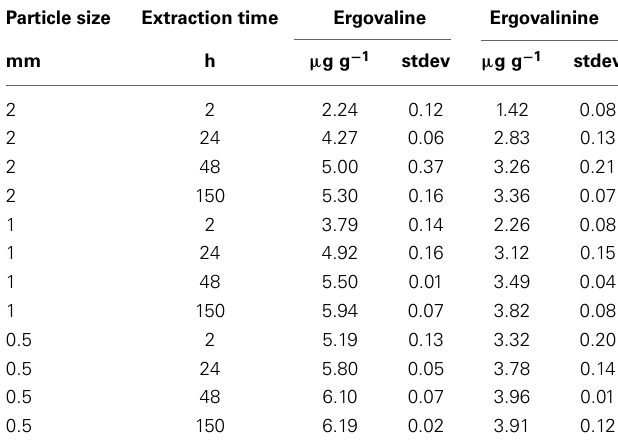
Table 2 | Extraction time, particle size interaction for efficient extraction with 80%